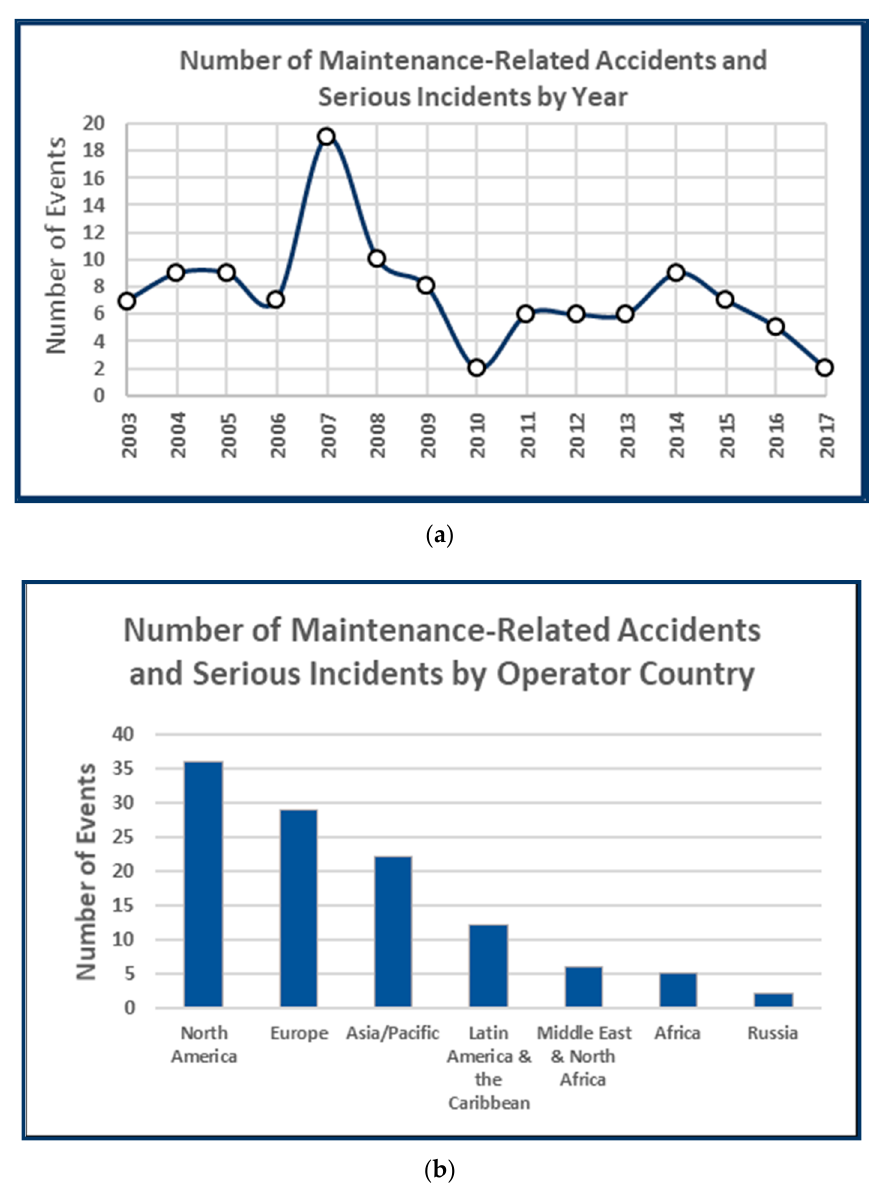
Figure 4. ( a ) Number of serious incidents and accidents identified for 2003–2017. ( b ) Number of serious incidents and accidents (2003–2017) by operator location.